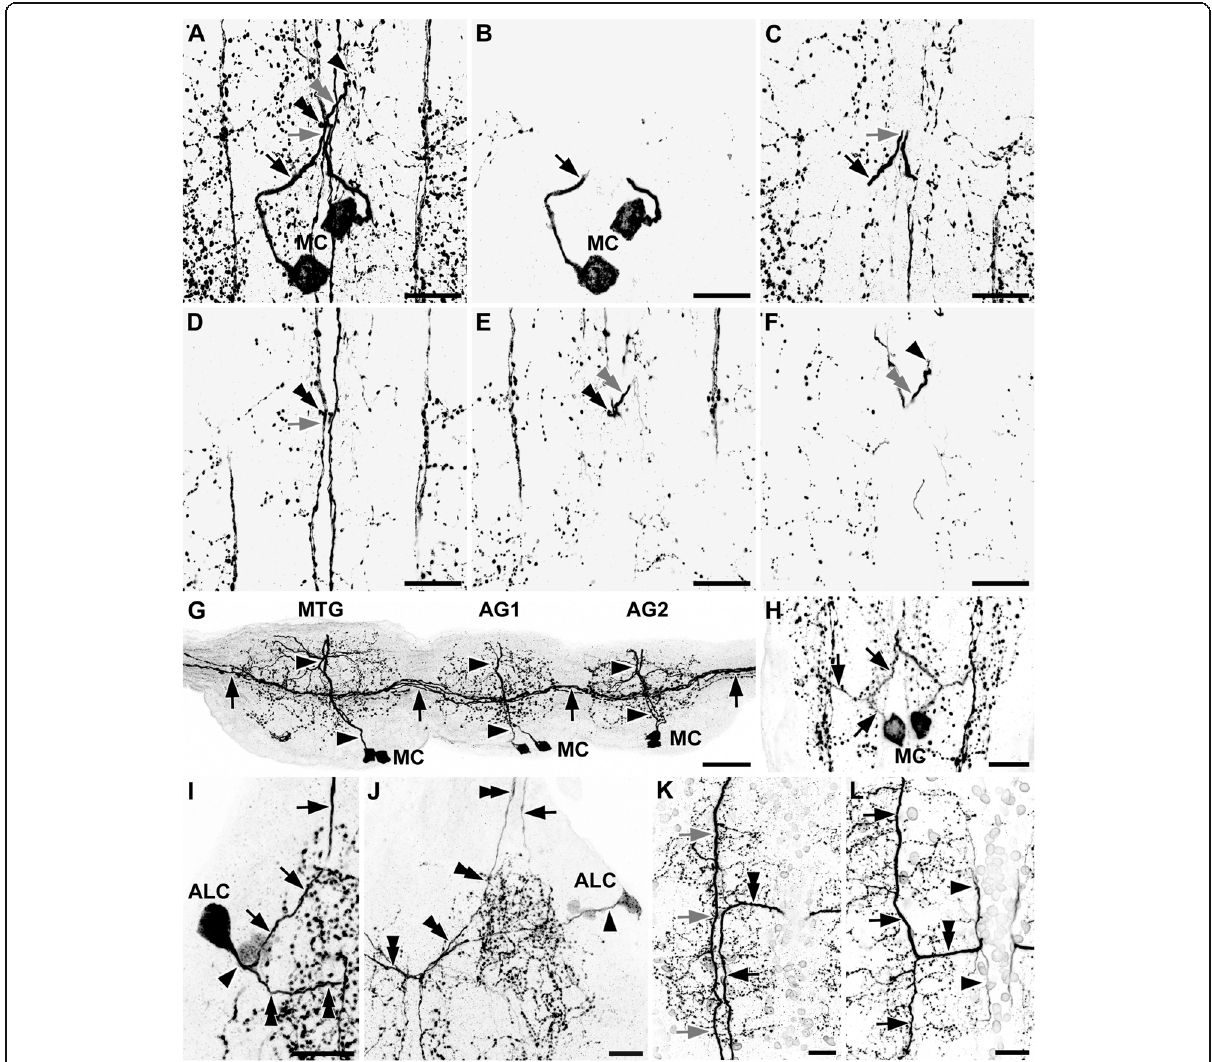
Fig. 2 Morphology of primary neurites of the histaminergic neurons in Thermobia domestica . Maximum projections of cLSM stacks (a – f, h – l: ventral view, anterior to the top; g: sagittal view, anterior to the left, ventral to the bottom). a – f Ventral-to-dorsal series of maximum projections revealed a contralateral projection associated to medial cell bodies (MC). a shows the complete stack, which is split in b to f. Same arrow types point to the same positions throughout the series (e.g., grey arrows in a, c, d). g Sagittal view of the metathoracic (MTG), first and second abdominal ganglia (AG1 – 2), showing the dorsomedial projections of the MC (black arrowheads). A strongly labeled longitudinal tract consisting of several axons is also visible (black arrows). h Projections of the MC in the abdominal ganglia. The primary neurite splits shortly after leaving the cell body in an ipsilateral and a contralateral branch (black arrows). i, j The large anterolateral cell bodies in the prothoracic ganglion projected medially (black arrowheads). Shortly after leaving the cell body, the primary neurite split into an ipsilateral branch, which entered the anterior connective (black arrows). The other branch projected further medially, crossing the ganglionic midline (dashed line) and entered the contralateral anterior connective (black double arrowheads). k, l One longitudinal tract projects without any specific branching through the ganglia (grey arrows in k). A second tract (black arrows in k and l), showed a medial horizontal branch (black double arrowhead in l) toward the ganglionic midline (dashed line). Ipsilaterally to the midline, this horizontal branch split again in a faintly labeled anterior and posterior tract (black arrowheads in l). Abbreviations: AG1 – 2: abdominal ganglia 1 – 2; ALC: anterolateral cell bodies; MC: medial cell bodies; MTG: